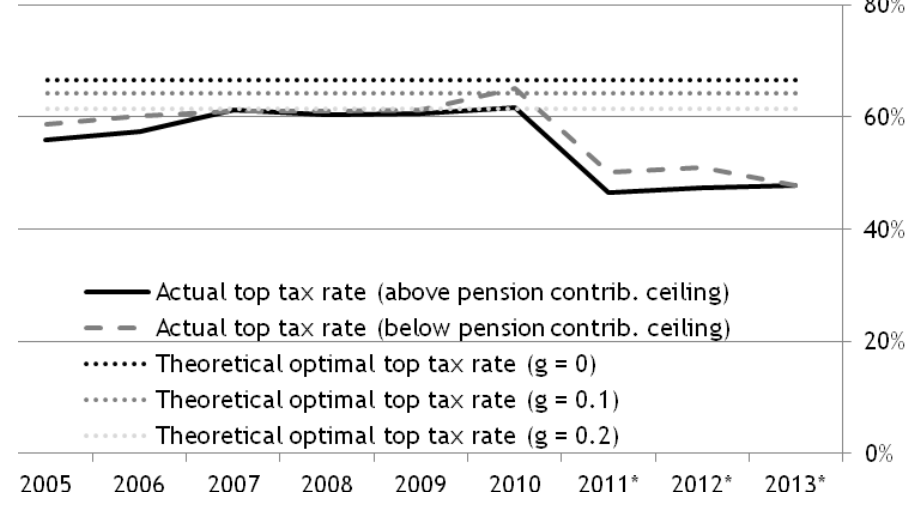
Figure 3. Actual effective top tax rates in Hungary under the assumption that the marginal link between pension contributions and future benefits is 50